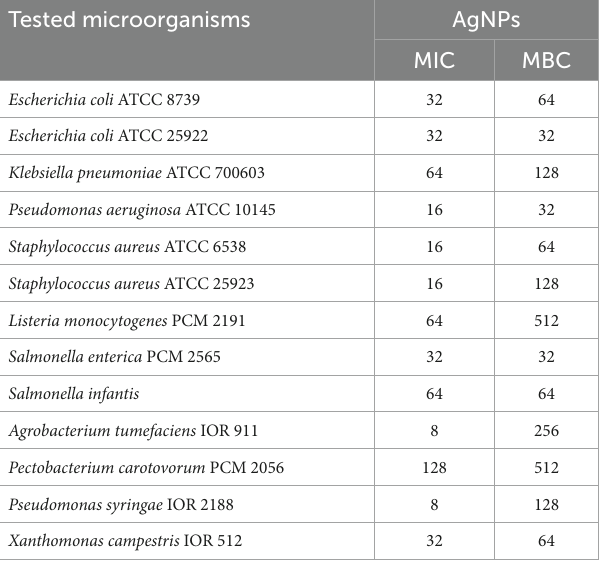
TABLE 1 Minimal inhibitory (MIC) and minimal biocidal (MBC) concentration values [ μ g mL − 1 ] of AgNPs against bacterial strains. Tested microorganisms AgNPs